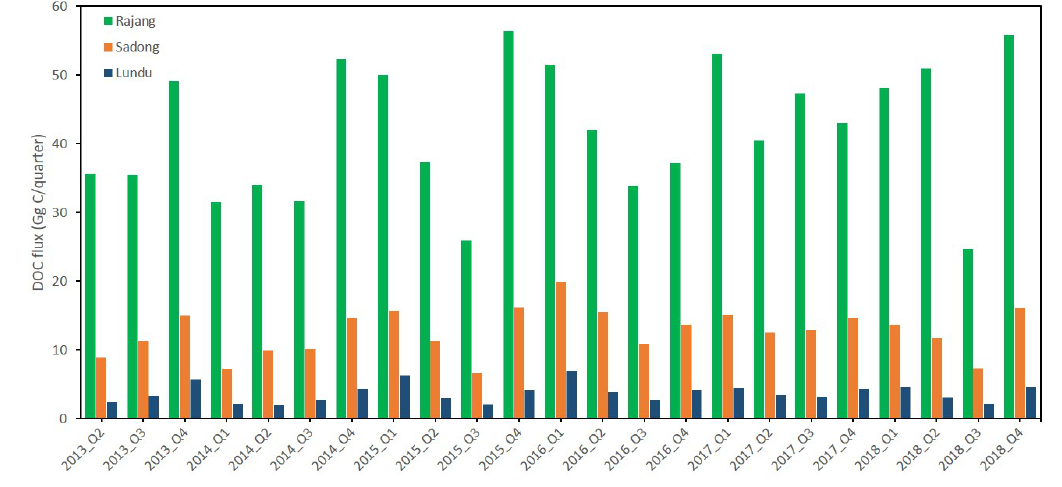
Figure 5. Quaterly DOC fluxes calculated using our new method between 2013 to 2018 for coastal waters off the three basins Rajang, Sadong and